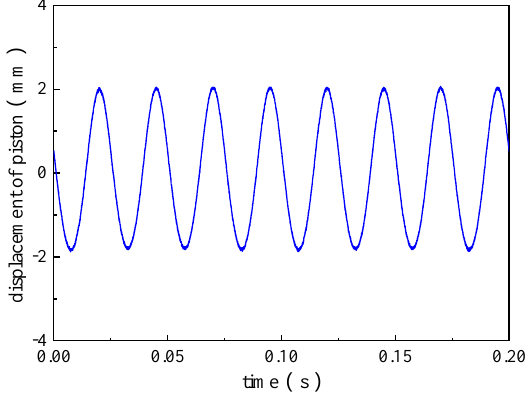
Figure 14. Piston displacement waveform during steady state generating test.